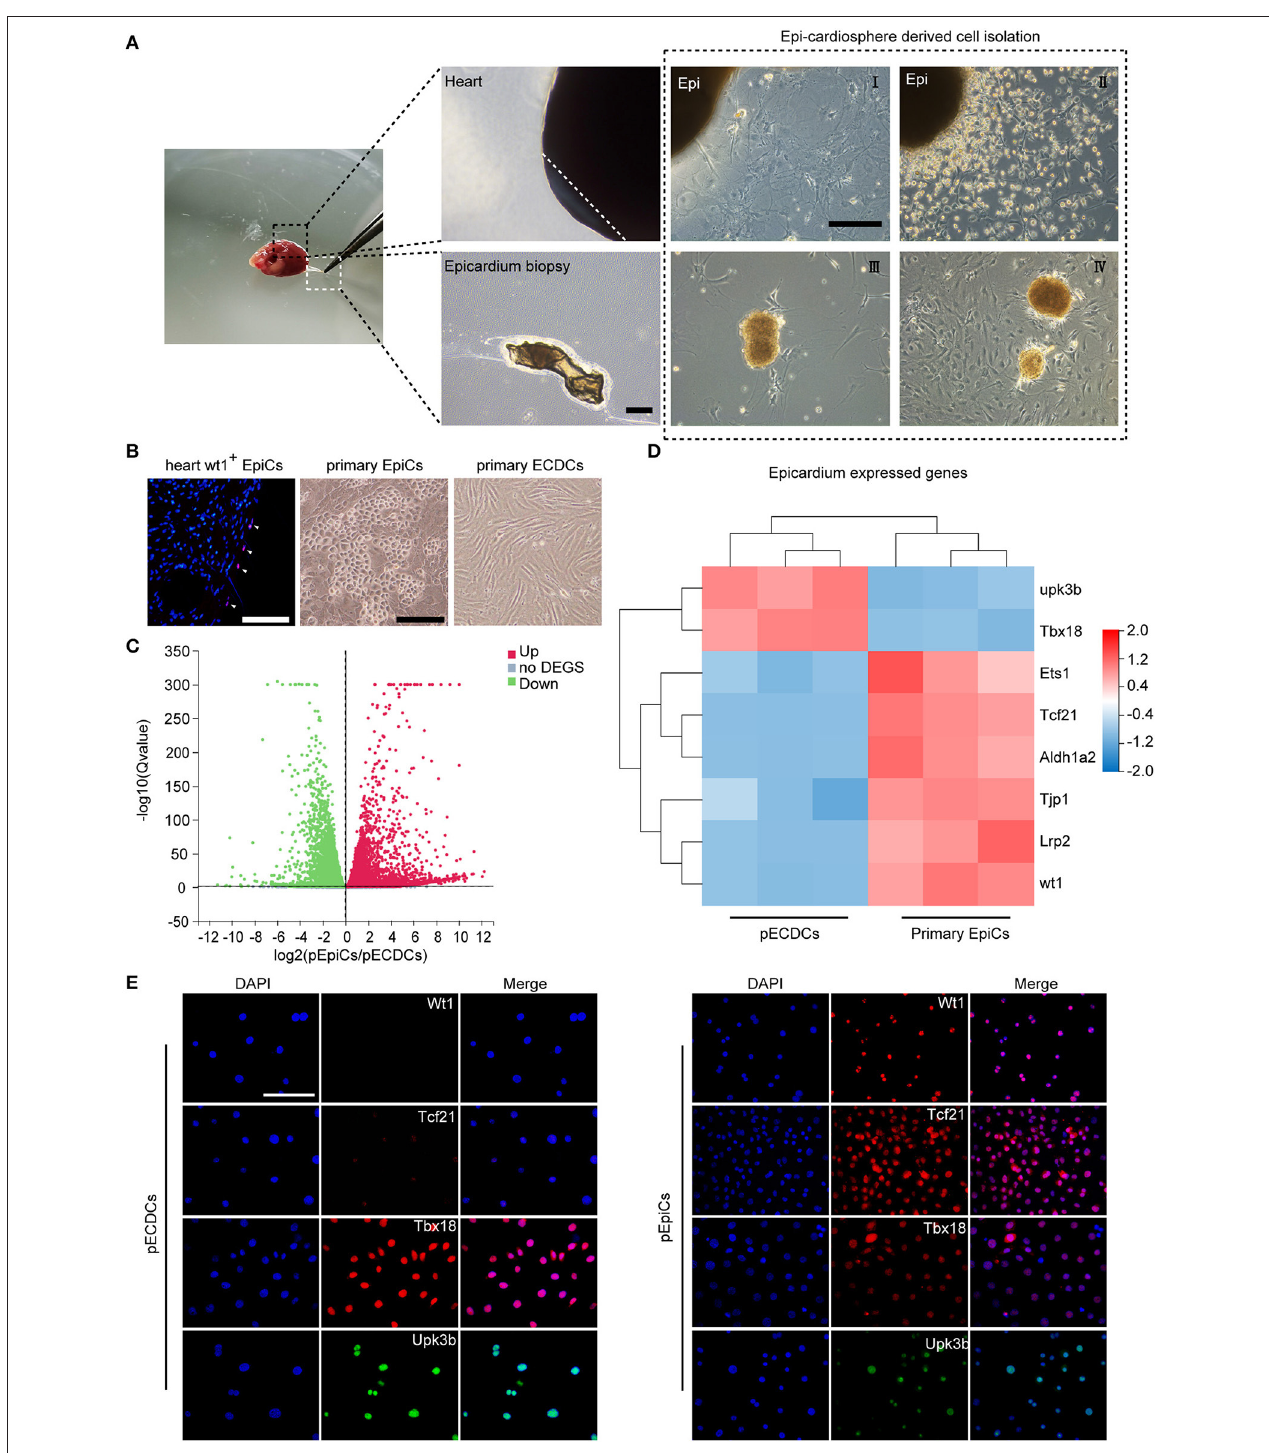
FIGURE 1 | Isolation of primary epicardium cardiosphere-derived cells (pECDCs) and gene expression profile analysis compared with primary epicardial cells (pEpiCs). (A) Isolation and culture of pECDCs from adult mouse ventricle epicardium (scale bar = 100 µ m). (B) Heart Wt1 + EpiCs staining and bright morphology of isolated primary pECDCs and pEpiCs (scale bar = 100 µ m). (C) Differential gene expression volcano plot of RNA sequencing results of pECDCs and pEpiCs. Data represent mean ± SEM ( n = 3). (D) Heatmap analysis of epicardium-related genes to compare pECDCs with pEpiCs. Expression levels were identified with different colors in which red represents upregulation and green represents downregulation. (E) Immunostaining of T-box transcription factor 18 (Tbx18) and other epicardium markers of pECDCs and pEpiCs (scale bar = 100 µ m).